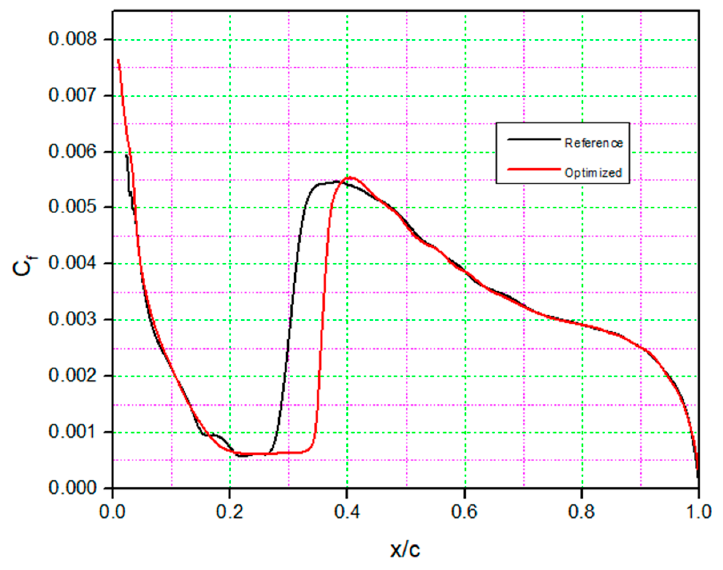
Figure 13. Comparison of the skin friction coefficient for the S45 optimized airfoil and for the reference airfoil for drag minimization.